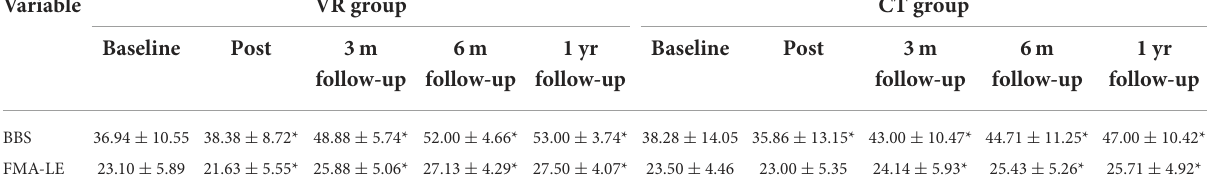
TABLE 3 Balance and lower motor function results of pre, post and follow-ups between CT and VR group.